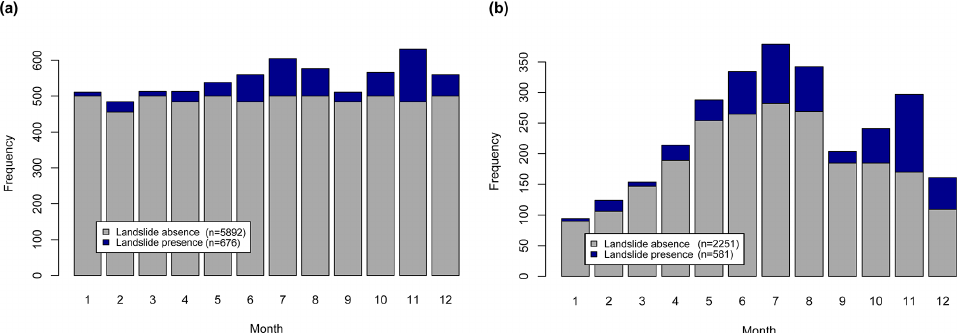
Figure 4. Overview of the distribution of presence observations (selected IFFI data) and absences observations across the months. The initial presence–absence sample before excluding non-precipitation days (a) and the final modelling sample after excluding non-precipitation days (b) . The distribution of grey bars in panel (a) reflects that each day of the year has an equal chance of being sampled, with the number of absence observations in each month being proportional to the number of days in each month. The grey bars in panel (b) depict that the distribution of precipitation observations based thereon is considerably higher during summer.